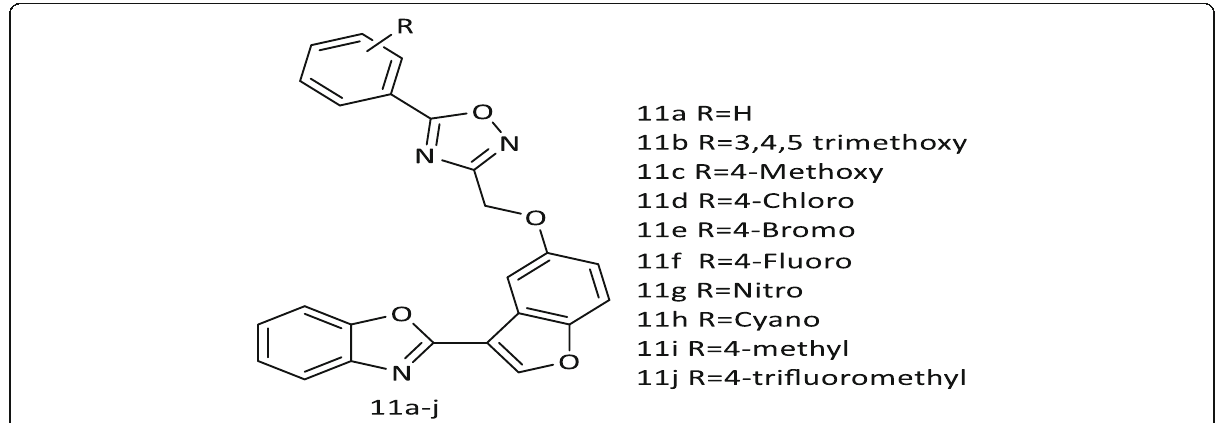
Fig. 4 Benzoxazole-1,2,4 oxadiazole